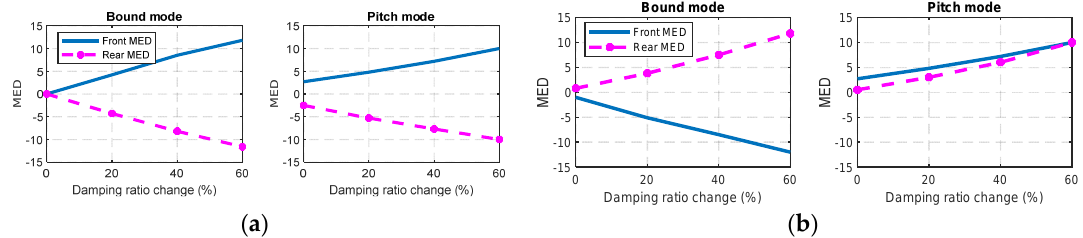
Figure 10. Changes of MED in different positions of damper faults. ( a ): MED changes caused by faults in left-front damper; ( b ): MED changes caused by faults in right-front damper.